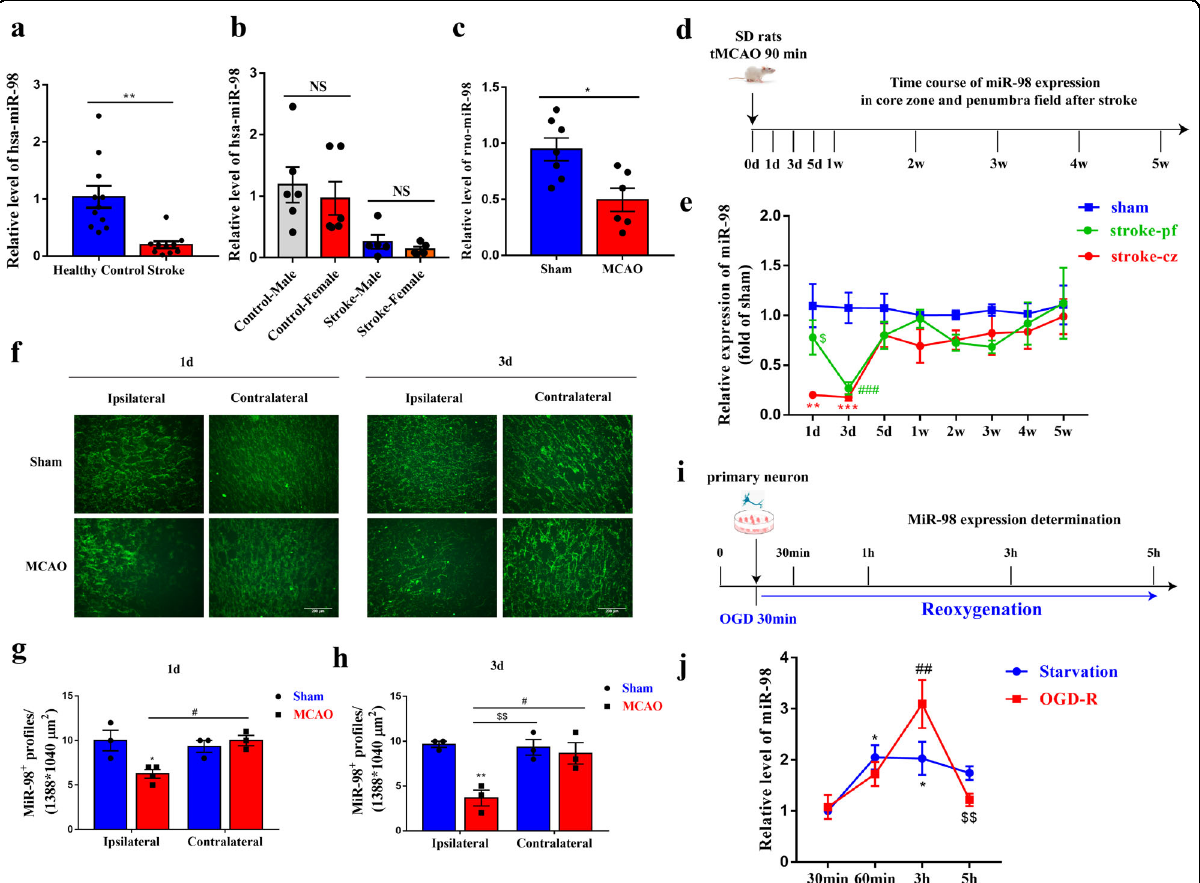
Fig. 1 MiR-98 participates in the acute phase of ischemic stroke. a – b The expression of miR-98 in the serum of acute stroke patients (both male and female) vs. healthy controls. c The expression level of miR-98 in the serum of acute stroke rats vs. sham groups. d – e The expression level of miR- 98 in the core zone and penumbra fi eld of rats after ischemic stroke from 1 day to 5 week ( N = 6 rats for each group). f – h Downregulation of miR-98 expression detected by fl uorescence in situ hybridization (FISH) in ipsilateral regions at 1 day and 3 day after ischemic stroke compared with contralateral regions and sham group and quanti fi cation. Scale bar = 200 μ m. ( N = 3 rats for each group). i – j The determination of the miR-98 expression level alterations of primary neurons treated with 30-minute OGD and reoxygenation 30 min, 1 h, 3 h, and 5 h compared with starvation treatment (removing B27). ( n = 3 independent experiments). Data are means±S.E.M., n = 8 mice/group. * P , # P , $ P < 0.05; ** P , ## P , $$ P < 0.01; and *** P , ### P < 0.001 vs.